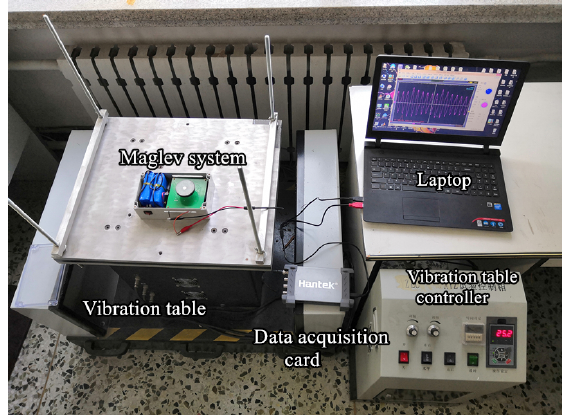
Figure 7. Electromagnetic suspension test